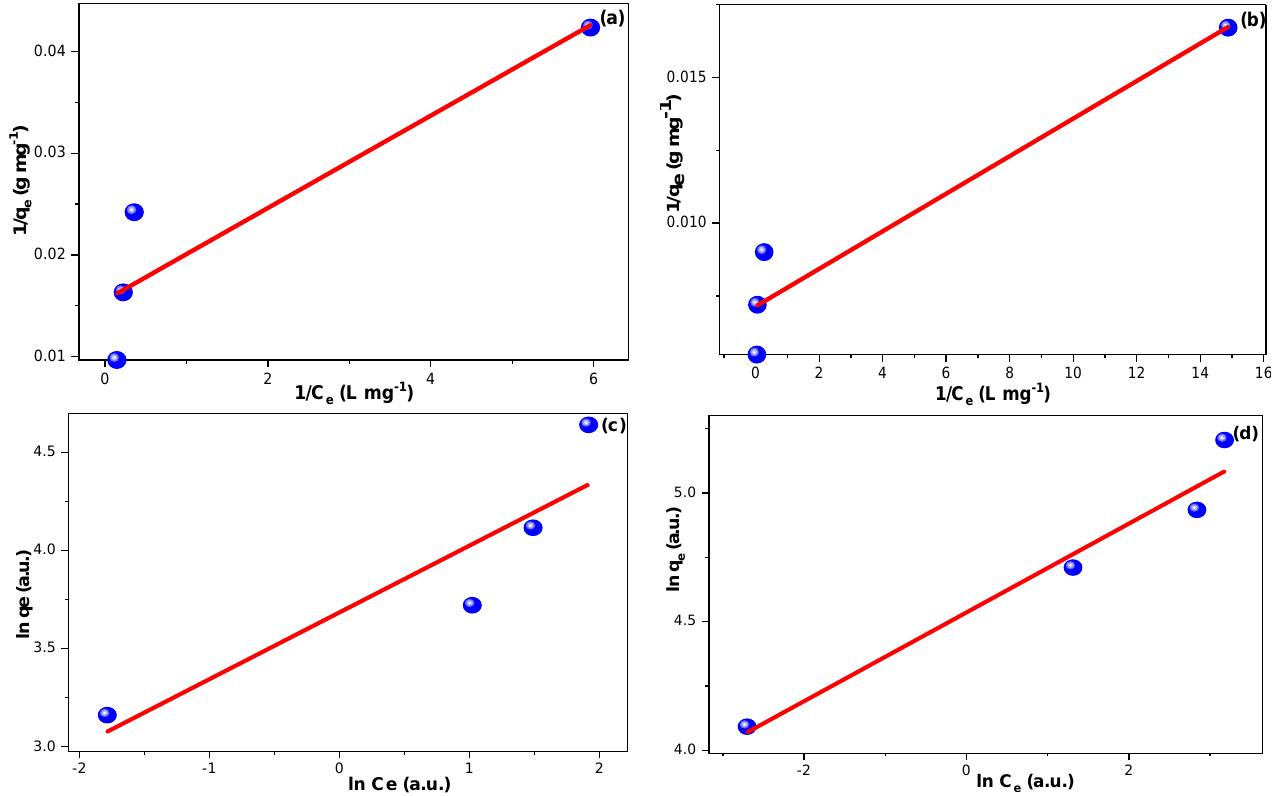
Figure 6. ( a ) and ( b ) present the Langmuir investigation for the adsorption of CFXN and MLG onto the CNPs, respectively; ( c ) and ( d ) show the Freundlich investigations for the same systems. The adsorption of CFXN on the CNPs showed a better fitting to the LI model, while the MLG adsorption followed the FI model. Although the 1/n values indicated favorable adsorption for both pollutants, the 1/n value for CFXN was double that of the MLG, indicating that CFXN sorption had less preference for the FI model [57]. Additionally, the 1/n values for CFXN and MLG on CNPs indicated reversible adsorption, which may imply a physisorption